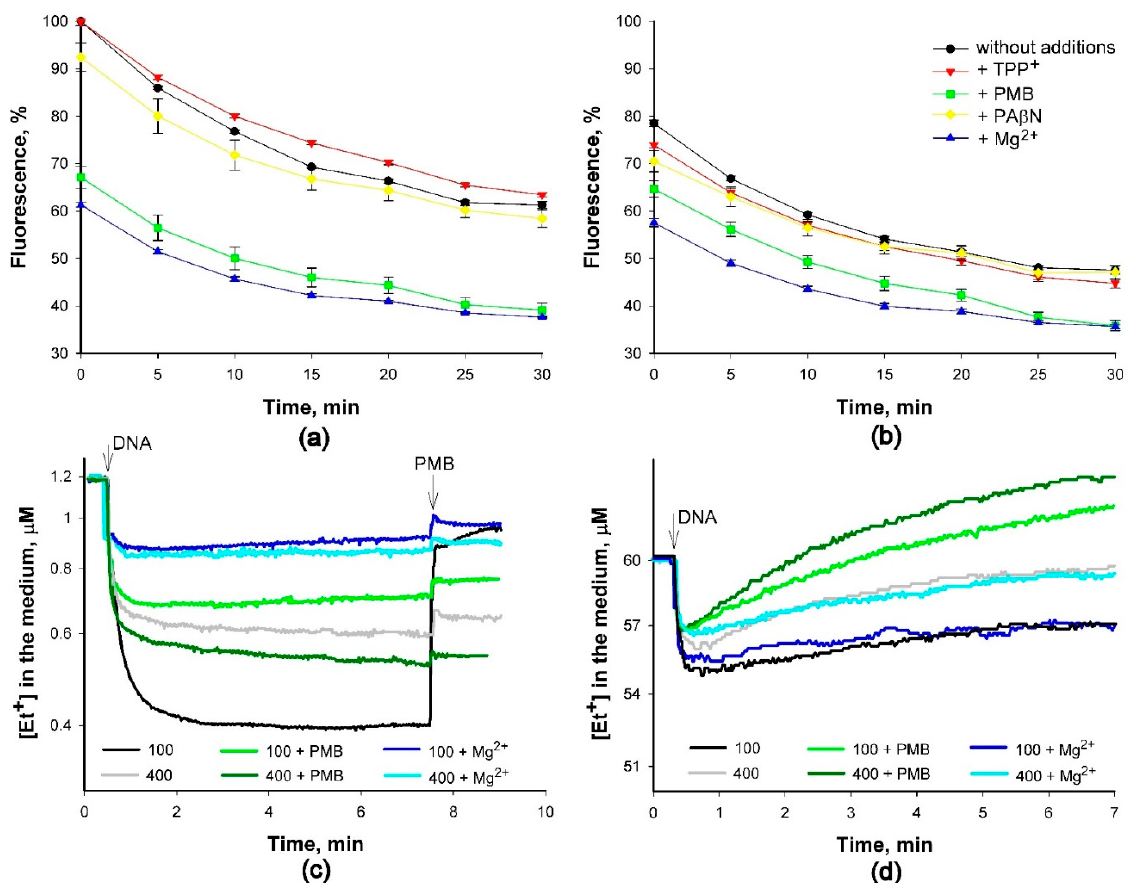
Figure 5. The influence of the medium composition on the interaction of Et + with DNA. Experiments were performed at 37 °C in 100 mM ( a , c , d ) or 400 mM ( b – d ) Tris/HCl buffer, pH 8. For ( a ) and ( b ), 100% intensity corresponds to the initial level of Et+ fluorescence in DNA solution in 100 mM Tris/HCl buffer. The concentration of salmon sperm DNA was 20 mg/L. The initial Et + concentration in ( a – c ) was 1.2 µM, in ( d ) 60 µM. Concentrations of PA β N, Mg 2+ , TPP + and PMB were 250 µM, 10 mM, 125 µM and 100 mg/L, respectively. In c, at the end of the experiment concentration of PMB was increased to 200 mg/L. Label in ( b ) is valid for ( a ), also.